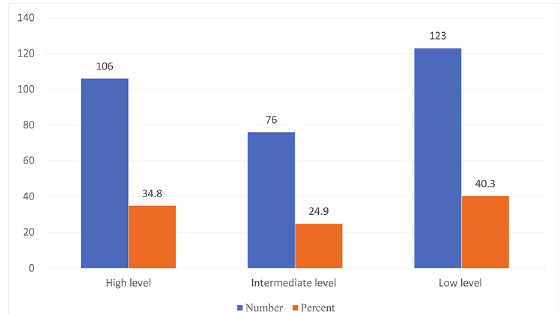
Figure 1. Distribution of the study subjects regarding knowledge level of dehydration in the elderly.